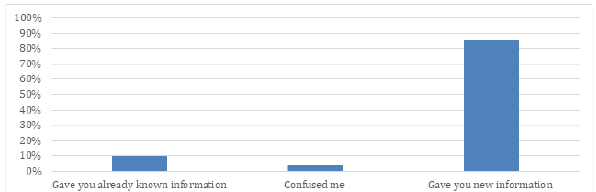
Figure 12. General satisfaction of the information gathered during the virtual visit